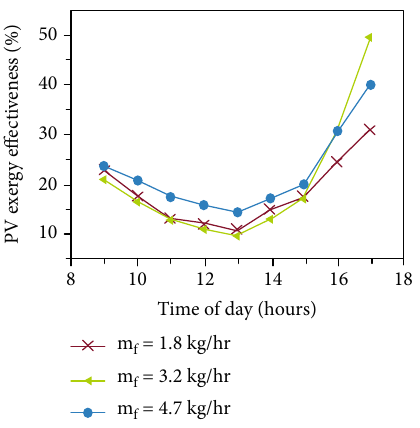
Figure 19: E ff ect of water mass fl ow rate on the PV exergy e ffi ciency during a day [66].